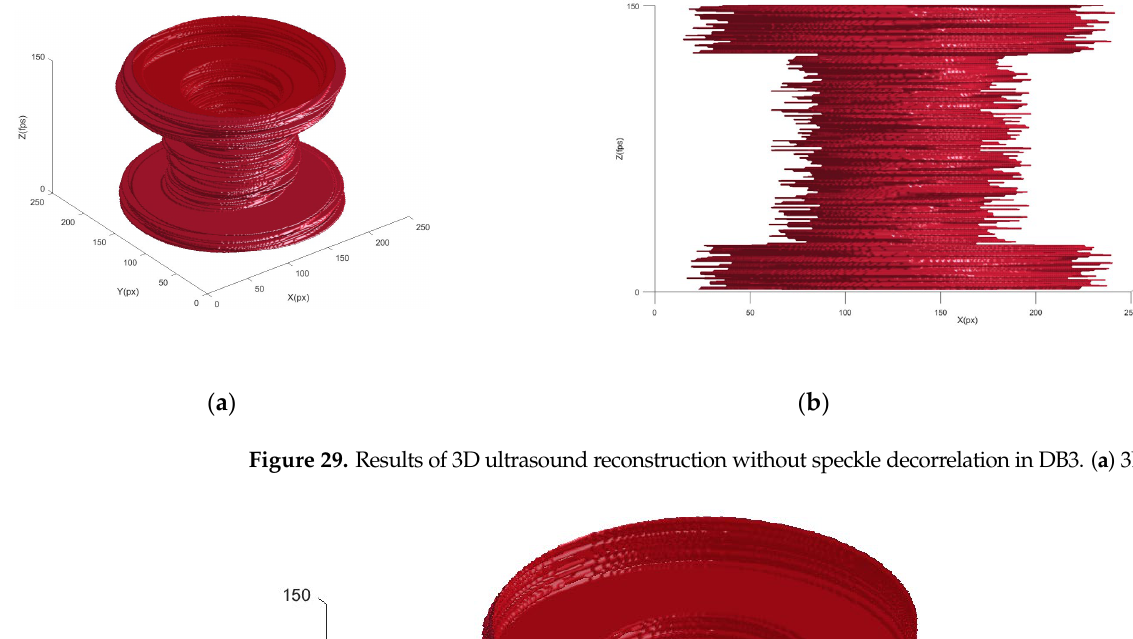
Figure 28. Results of 3D ultrasound reconstruction without Bezier interpolation in DB3. ( a ) 3D; ( b ) X-Z.